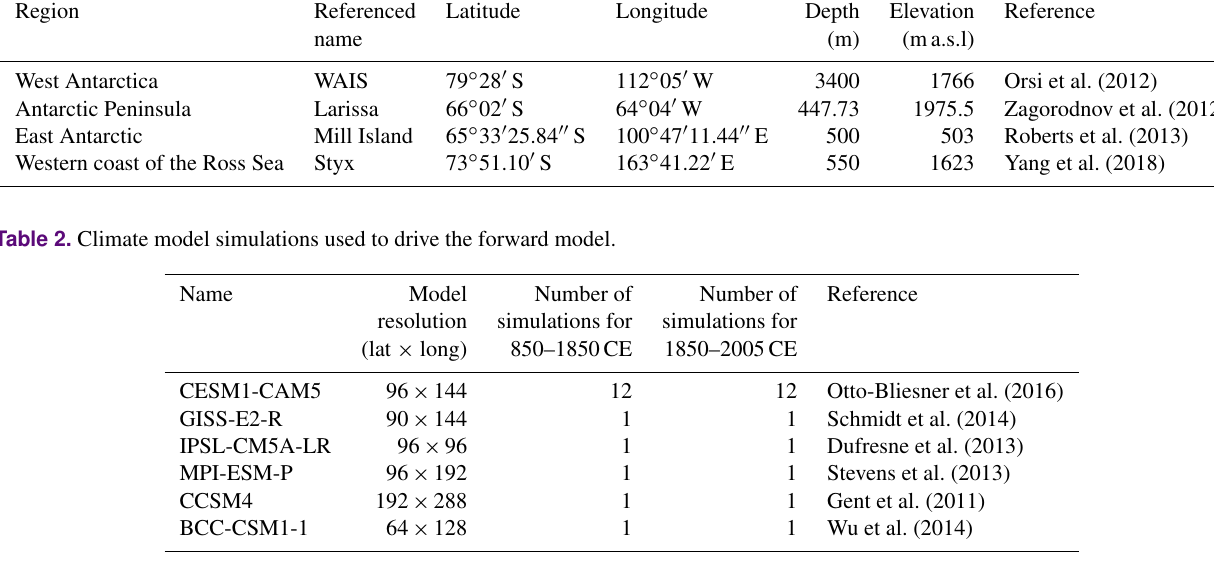
ent climate model results (solid lines in color in Fig. 2a and b). However, the initial temperature derived from a steady- state profile has an influence on the slope of the profile in